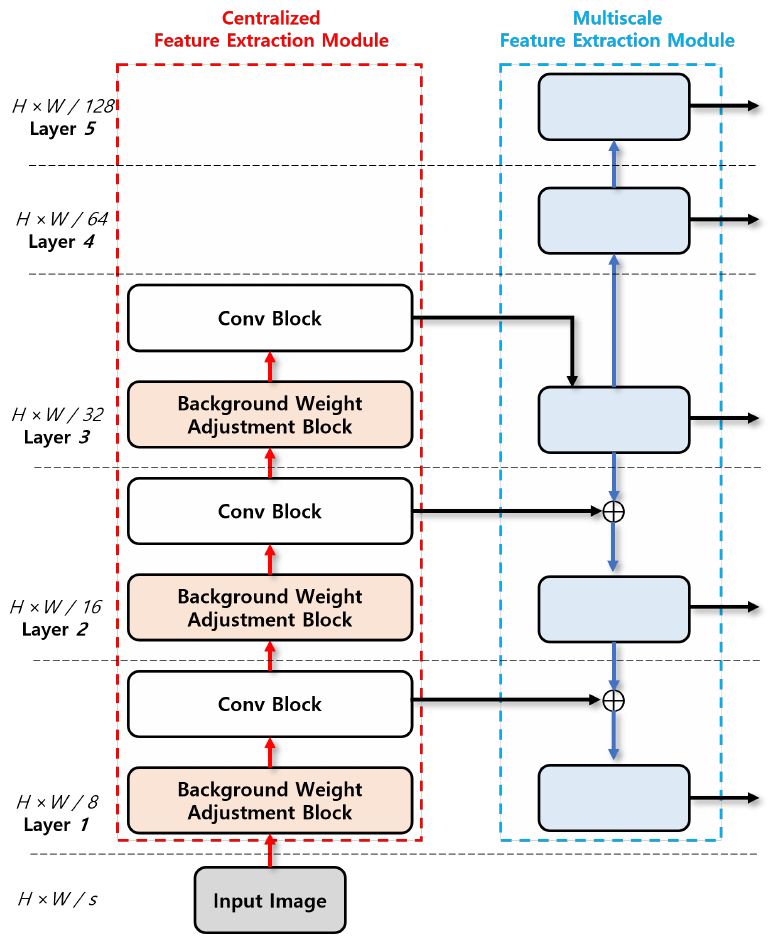
Figure 2. Centralized feature extraction